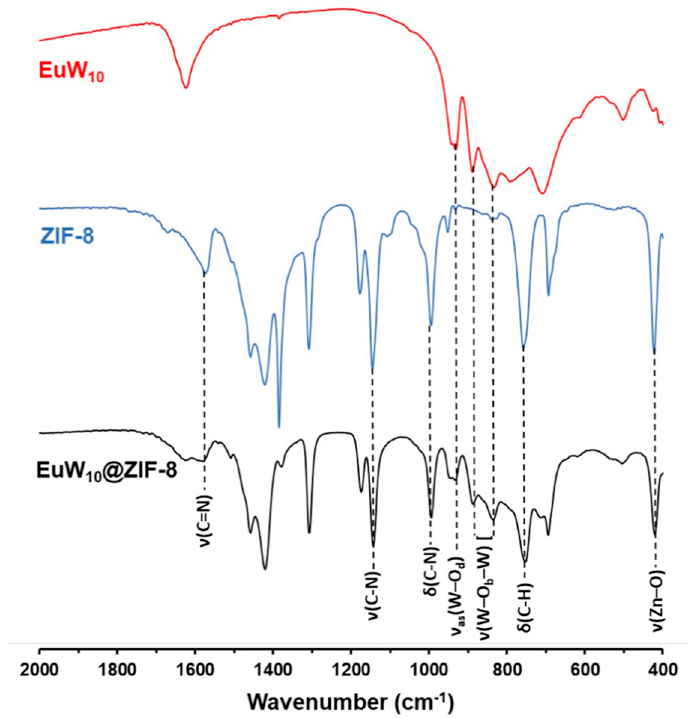
Figure 1. FT-IR spectra of the isolated EuW 10 , the ZIF-8 support, and the resulting EuW 10 @ZIF-8 composite.